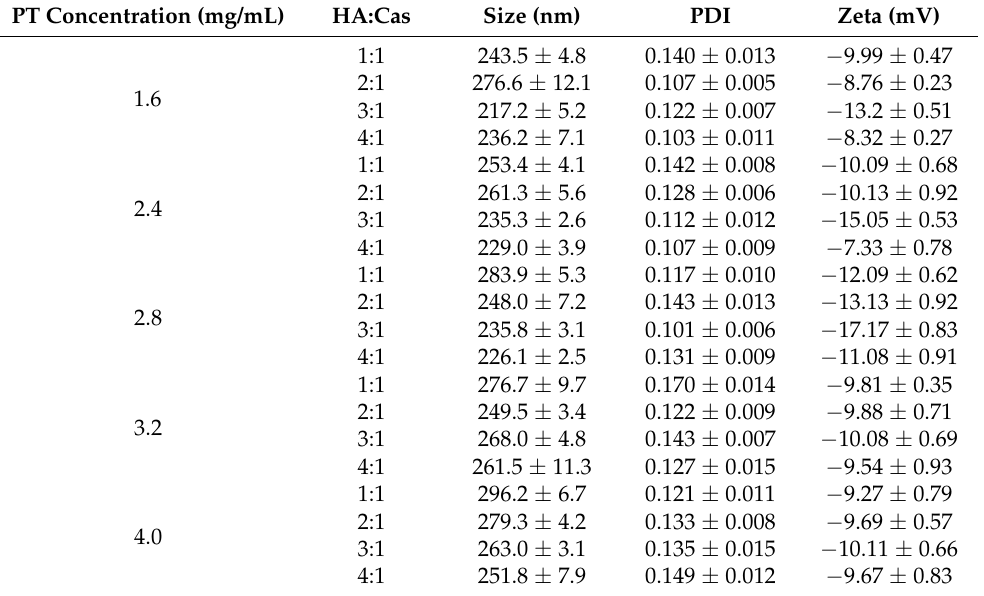
Table 1. Effects of PT concentrations and the HA/casein values on the particle size, PDI and zeta potential of